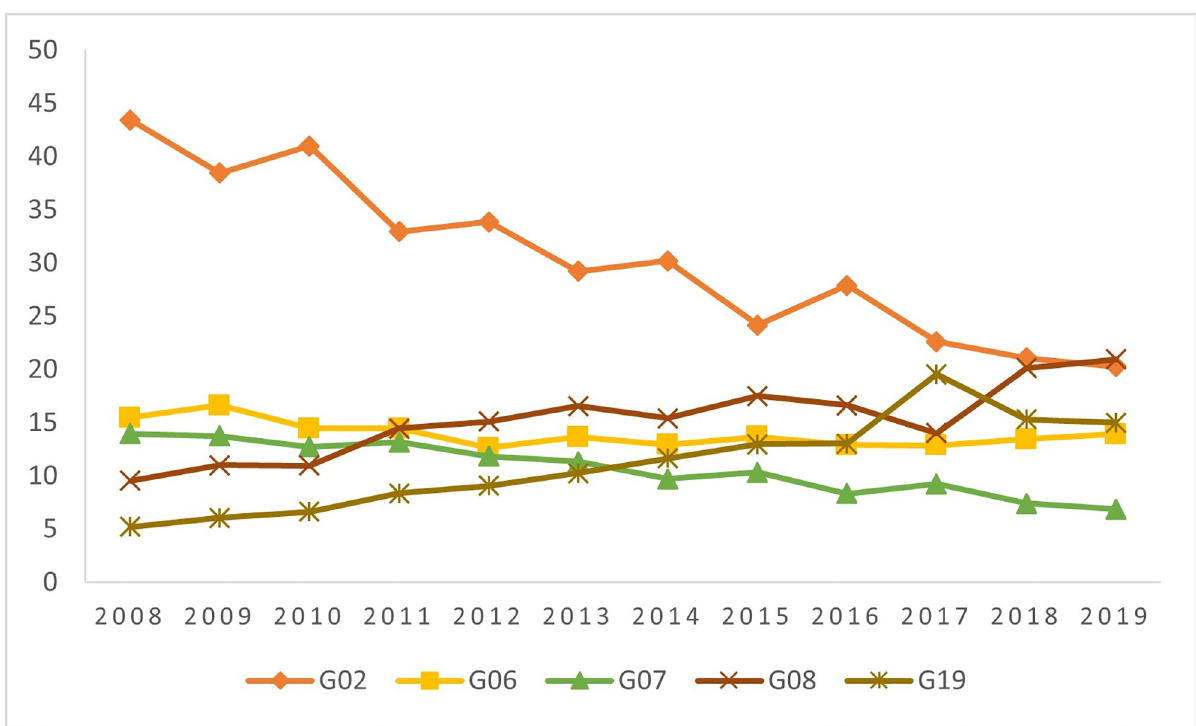
Fig 2. Proportion of ACSC by groups of causes, considering the five most frequent causes. Brazil, 2008–2019. G02—Infectious gastroenteritis and complications; G06—Bacterial pneumonia; G07—Asthma; G08—Lung diseases; G19—Diseases related to prenatal care and childbirth.